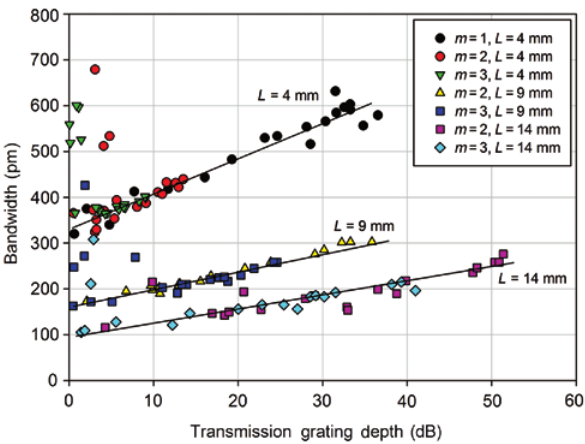
Figure 9: C-band WBG bandwidth as a function of grating depth for various WBG orders ( m ) and lengths ( L